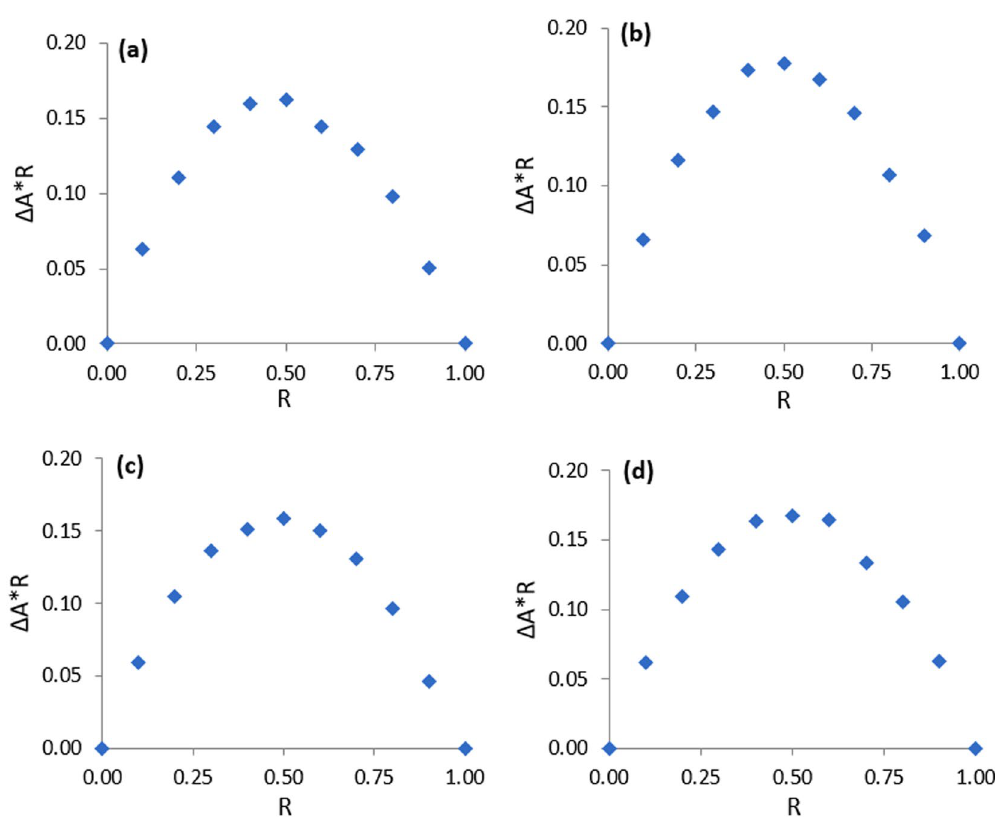
= 209 nm and (c) max = 219 nm, at 298.15 K. Δ A = absorbance difference of SNP/ max